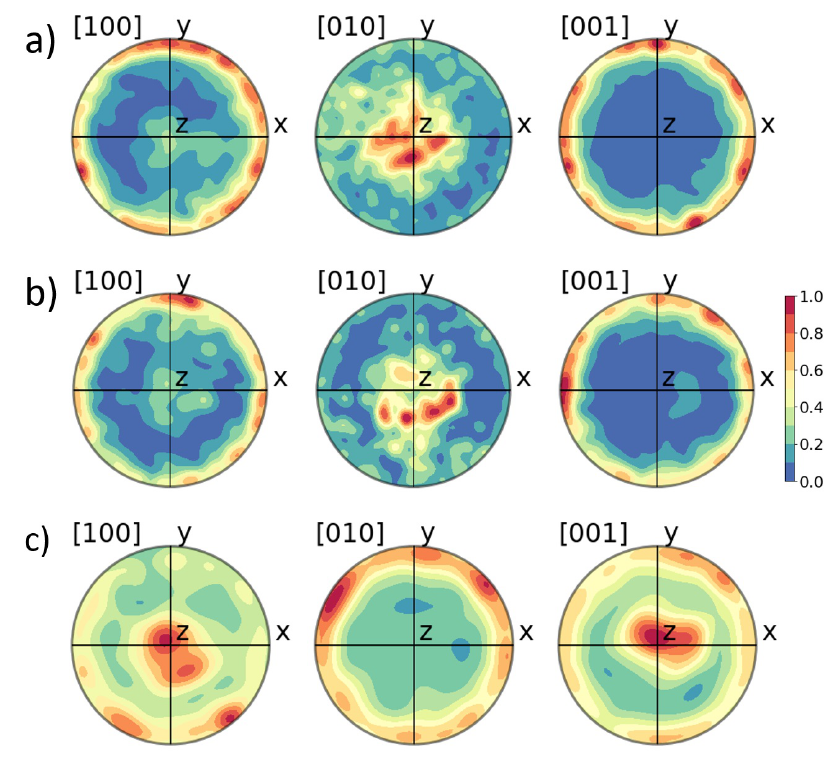
Figure 7. Shown are the pole figures of the [100]-, [010]-, and [001]-axes for orhorhombic grains in HZO